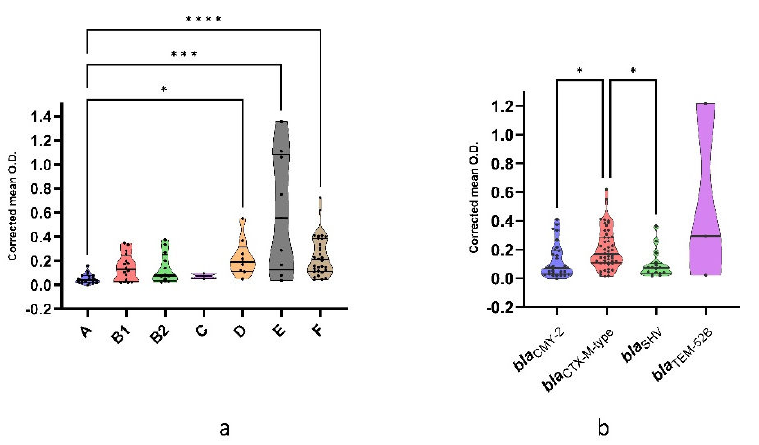
Figure 3. ( a ) Corrected mean O.D. among phylogroups. ( b ) Corrected mean O.D. among strains harboring different ESBL/pAmpC genes. Lines within violin plots represent median, 25th, and 75th percentile. p < 0.05 is shown as *, p < 0.005 as ***, and p < 0.0001 as ****.